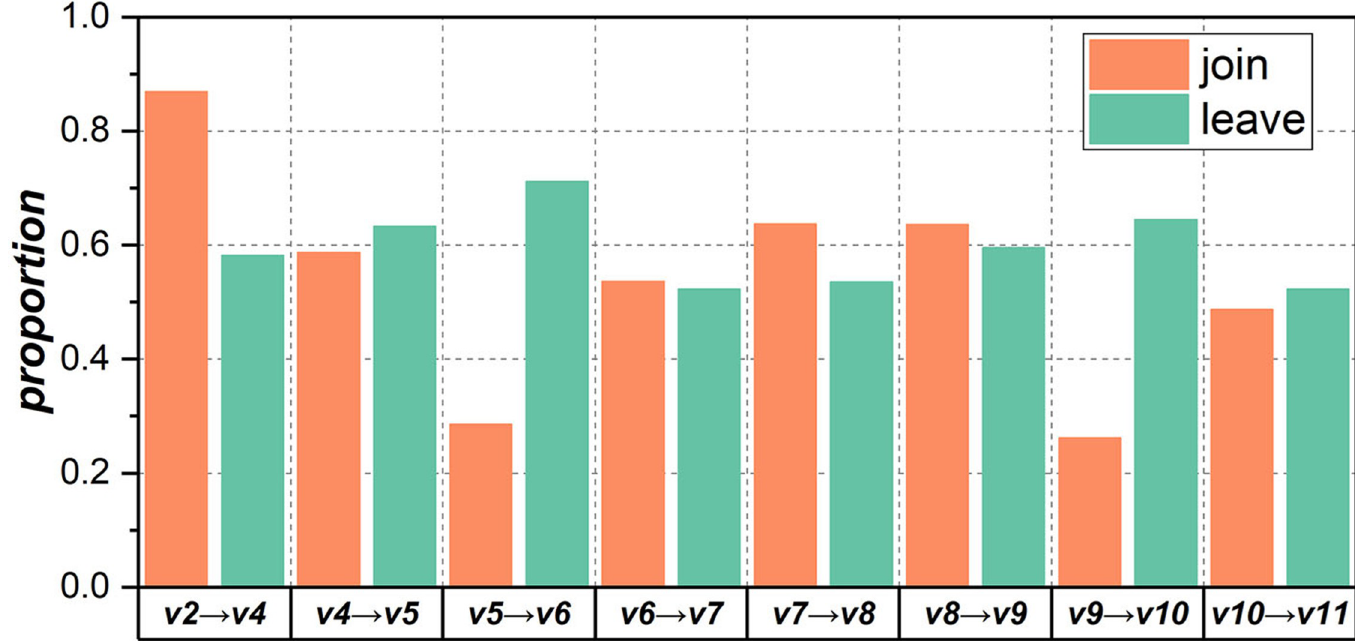
Fig 2. Variation among developers during the process of major version releases.